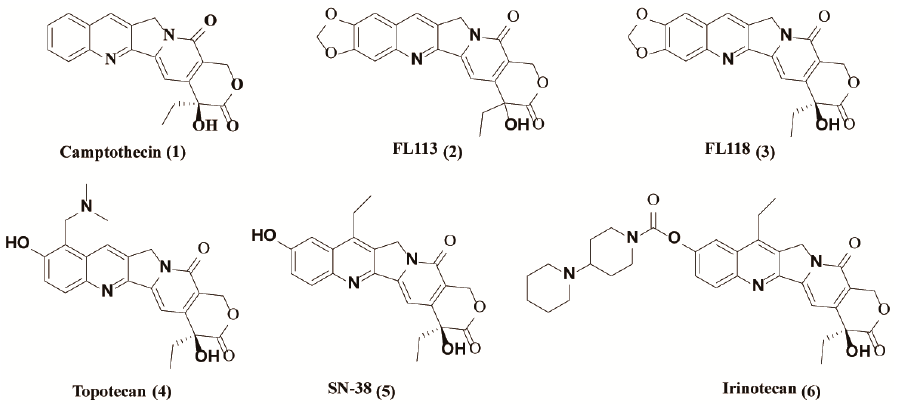
Figure 1. Structures of camptothecin derivatives.